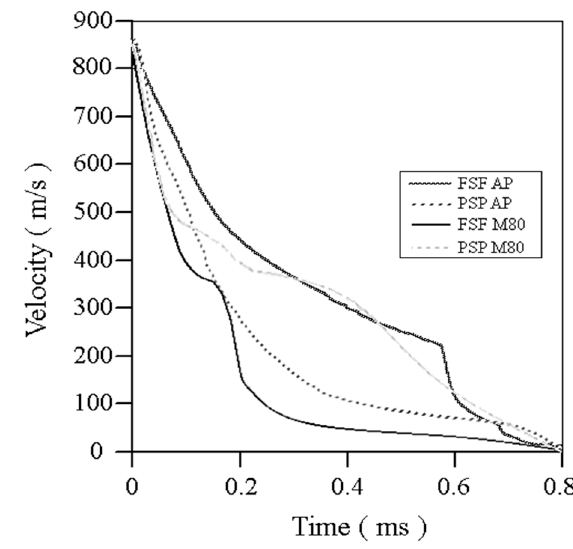
Figure 10. Numerical velocity results with respect to time obtained in the numerical simulations.